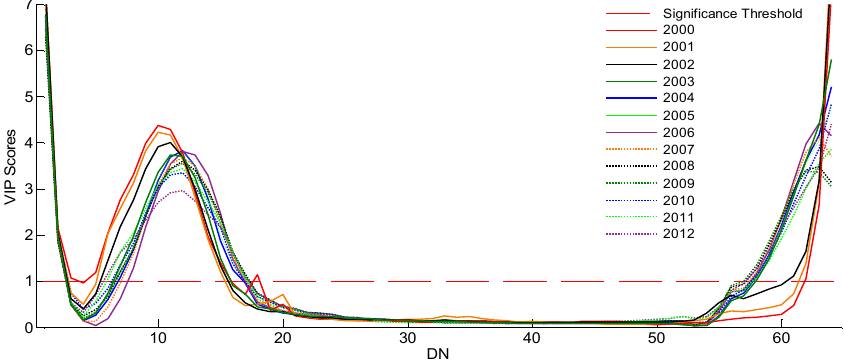
Figure 7. VIP scores for the entire DN series based on the estimation model.